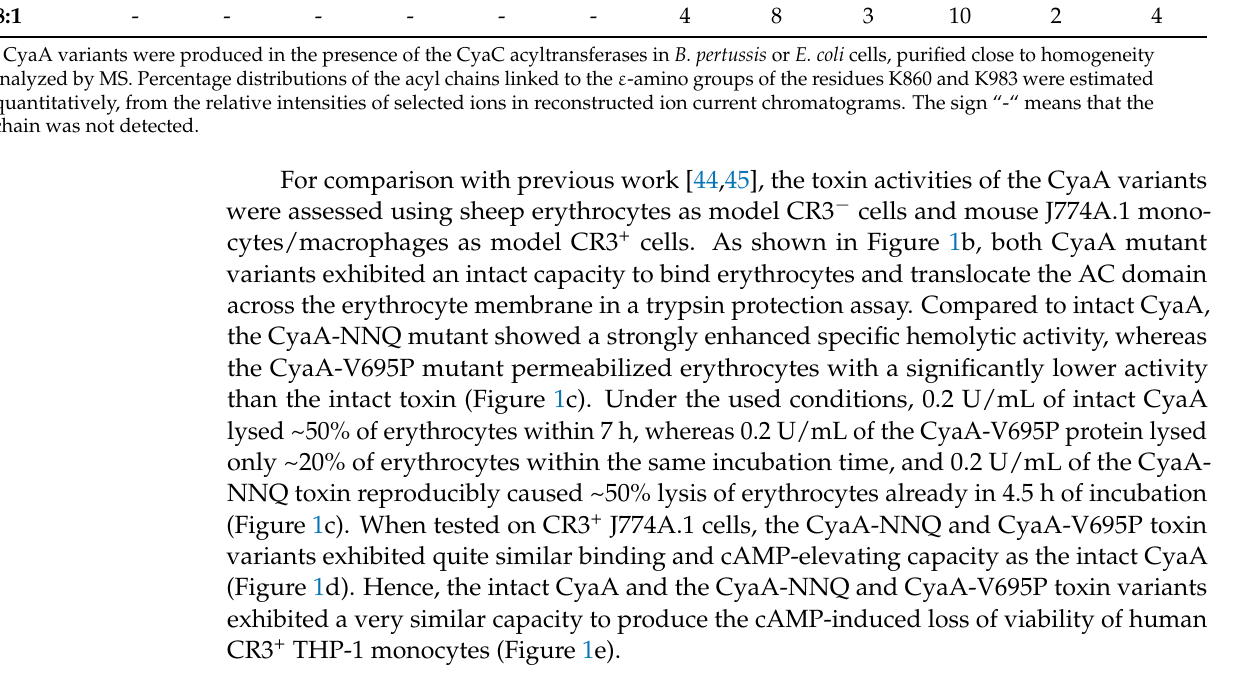
CR3 + THP-1 monocytes (Figure